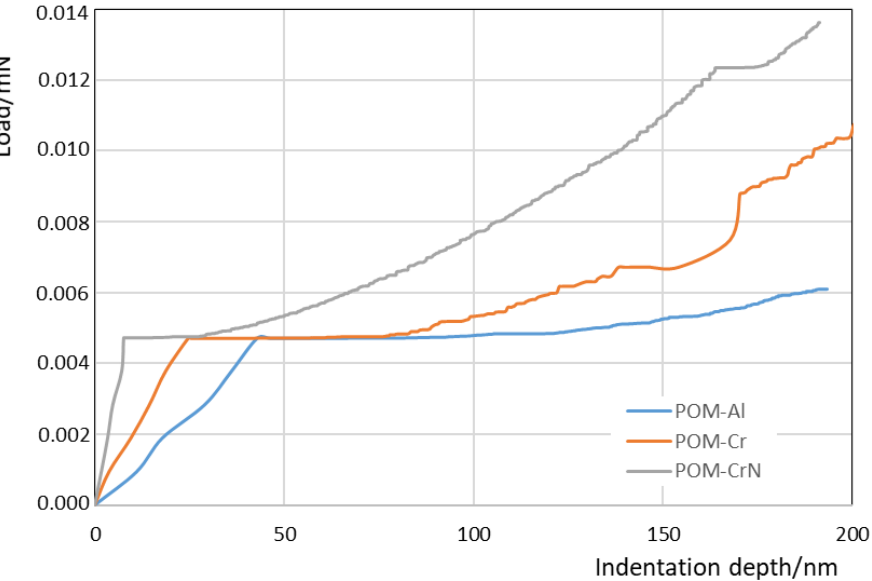
Figure 9. The loading curves obtained during indentations with a very low indentation rate (10 − 4 mN s − 1 ).